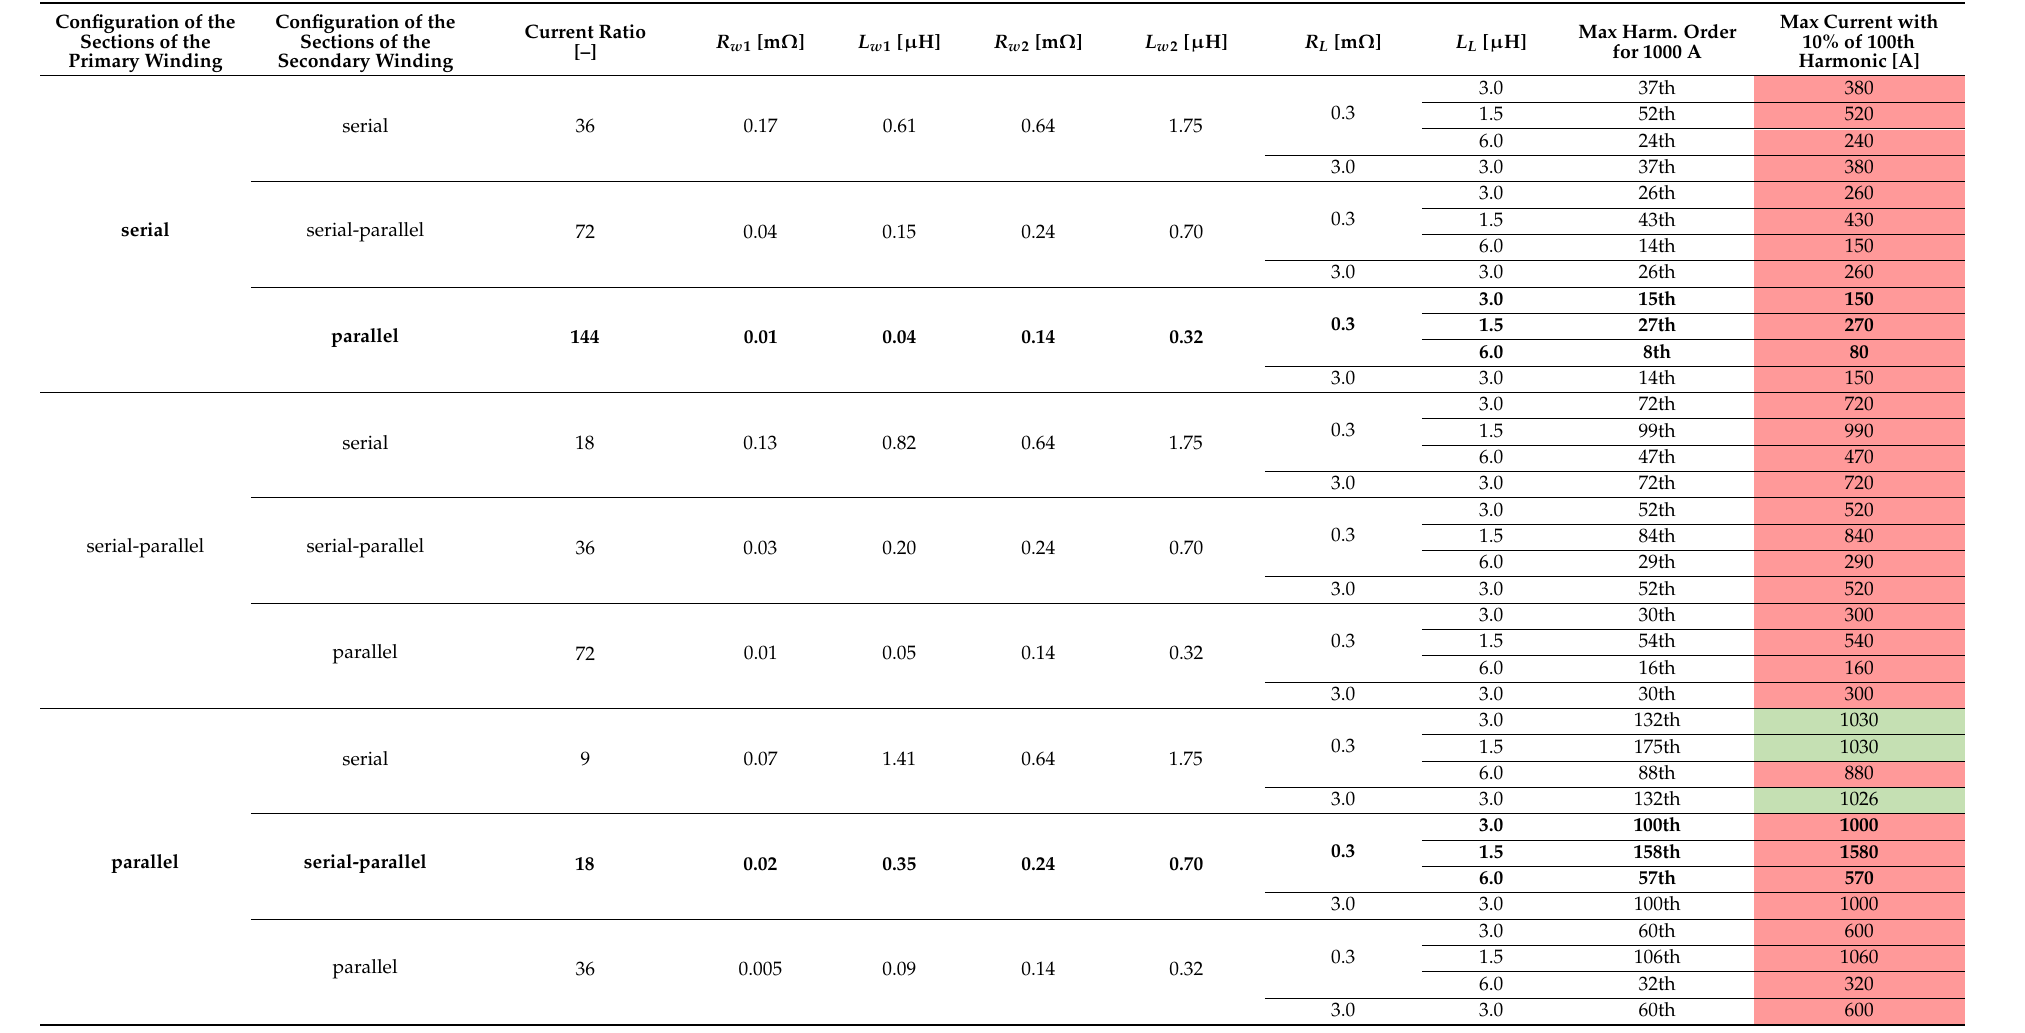
Table 2. Overview of the calculated maximum values of the secondary current with 100th order higher harmonic equal to 10% of the main component and obtained maximum higher harmonic order for the secondary current equal to 1000